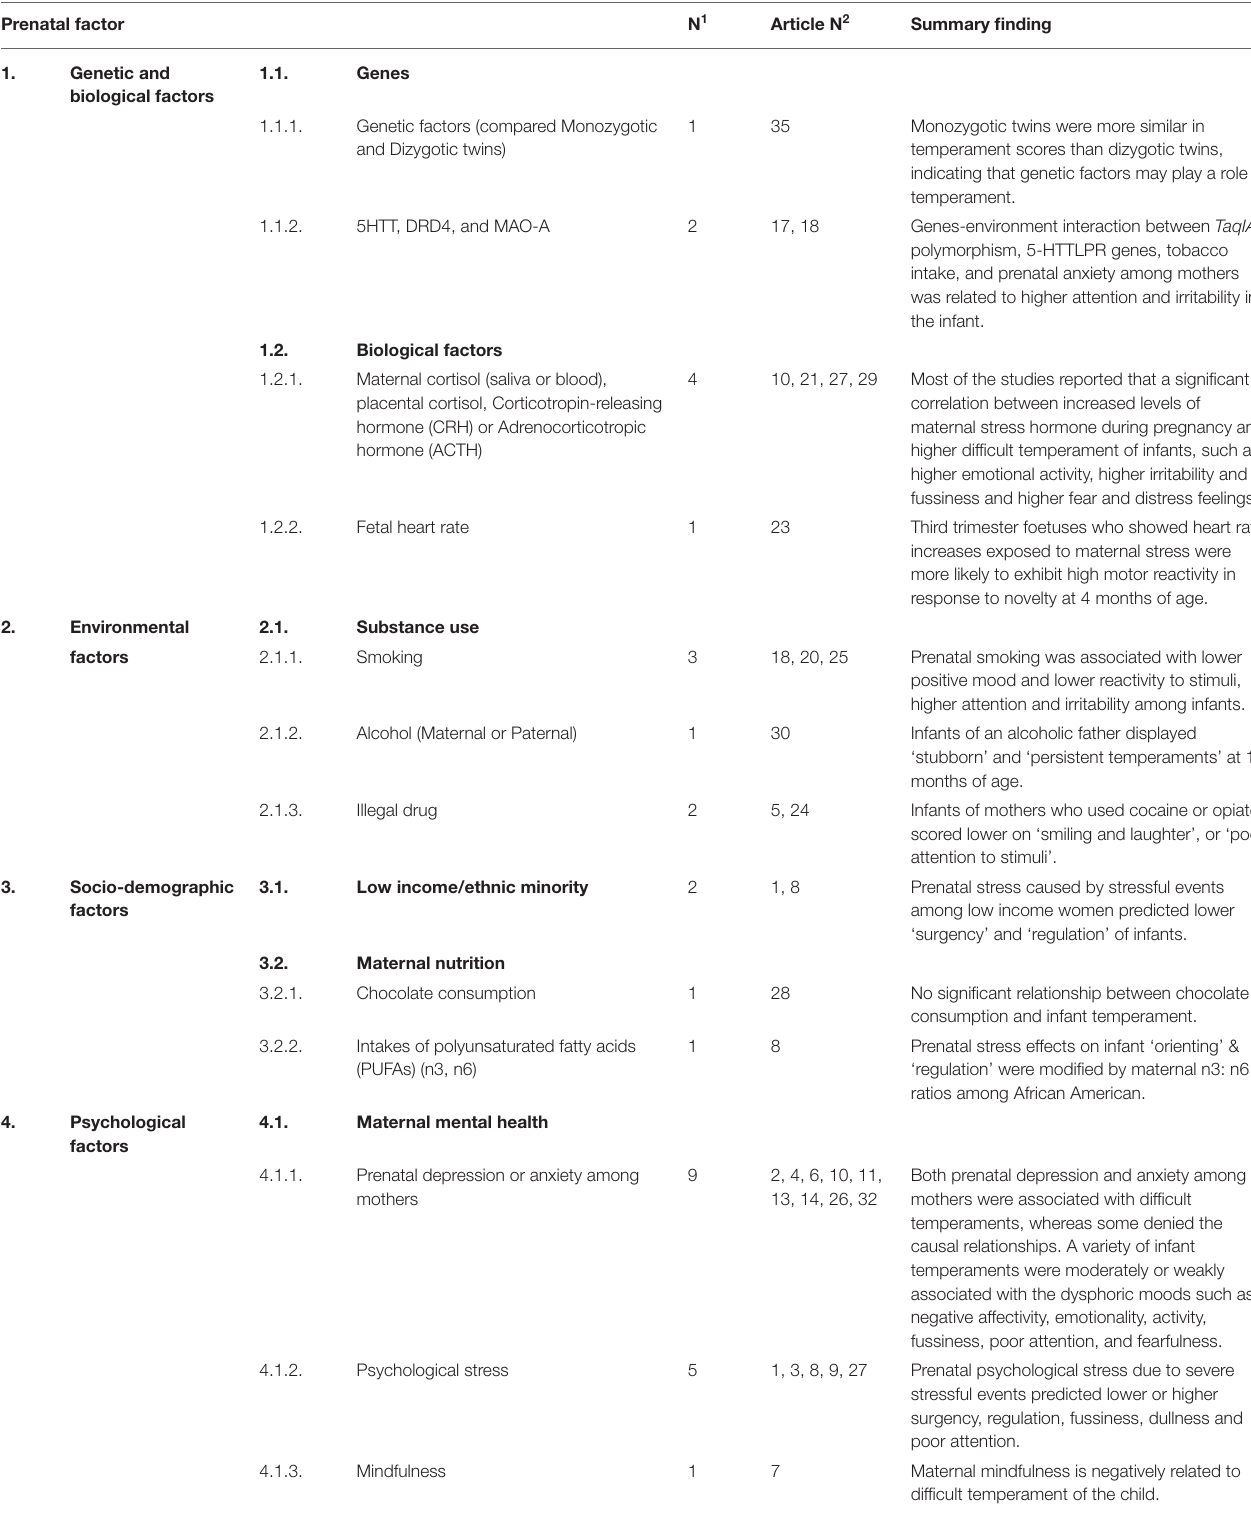
TABLE 2 | Findings of literature